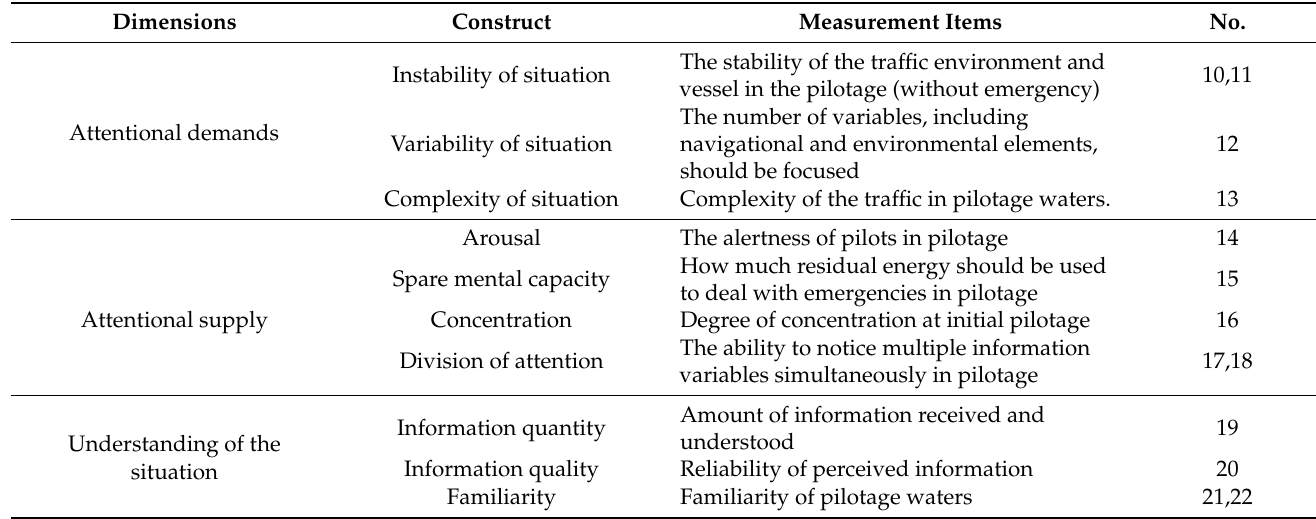
Table 3. 3D-SART measurement scale in ship pilotage.